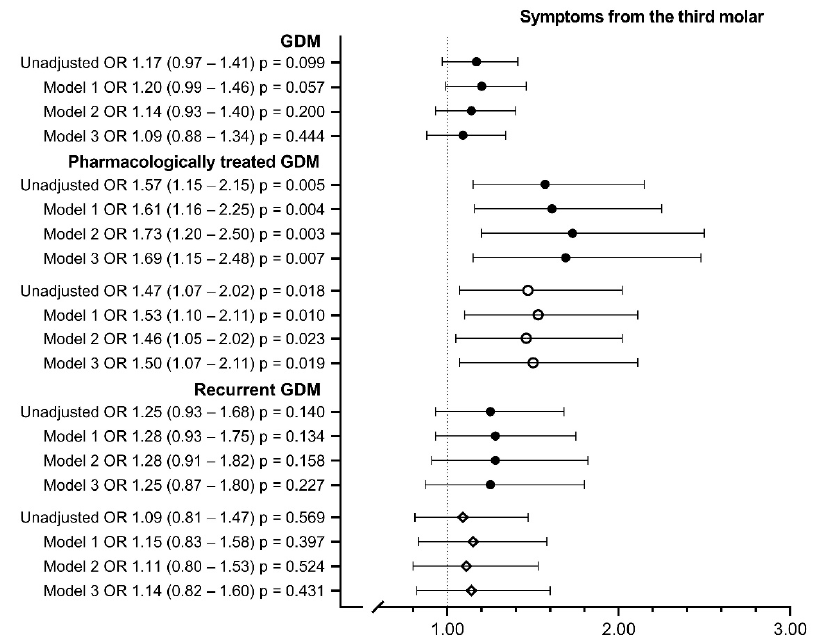
Figure 4. Third molar symptoms in women with gestational diabetes and its subgroups. Model 1 includes maternal age at birth and parity; model 2 includes model 1 + pre-pregnancy BMI; model 3 includes model 2 + smoking during pregnancy, educational attainment, asthma and insomnia and/or mental disorders. • Compared to controls. ◦ Compared to women with diet-treated GDM. ♦ Compared to women with first-onset GDM. Missing values were 2.3–3.4% in Models 1 and 2 and 7.7–8.1% in Model 3. OR, odds ratio; CI, confidence interval .